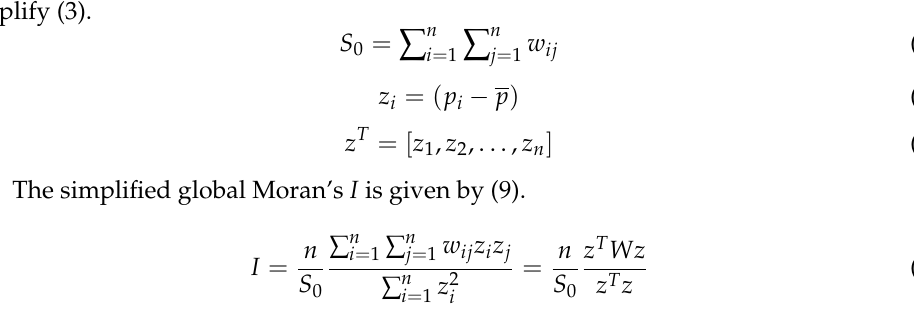
Figure 2. The structure of the multi-convolution neural network.